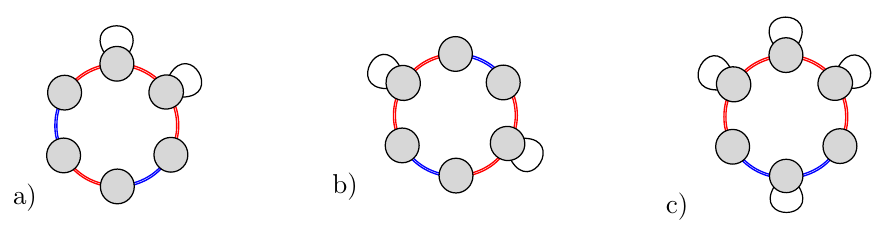
. The three quivers are related by 3